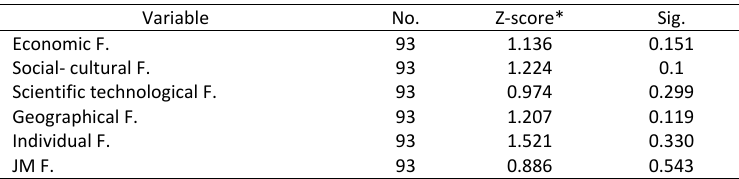
Table 4: Results of KS test for research variables